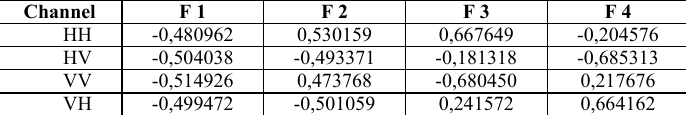
Eigenvalues of this matrix: 2,500798; 1.49511; 0.002731; 0.001361. Table 7 . Eigenvectors of the correlation matrix in a scene without a target Channel